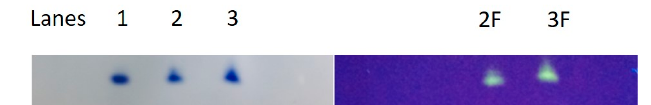
Figure 3. Reversed phase high performance liquid chromatography (RP-HPLC) of dendrimers: The retention time for G4-90/10 surface is 10.1 min and the retention time for Hen egg white lysozyme is 18 min. Comparable peak size between G4-90/10 dendrimers and lysozyme shows purity of the dendrimers.